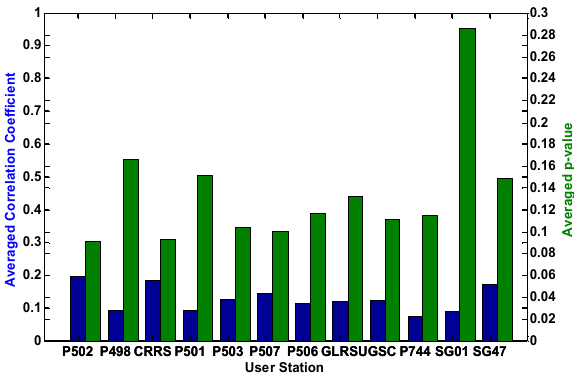
Figure 3. Average correlation coefficient between ZTD and slant ionospheric delays at user stations and p-vales for testing the hypothesis of no correlation.